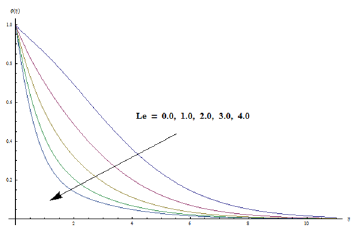
Figure 11. Variation in dimensionless concentration w ( g ) vs g for different values of Le when l 1 ~ 0 : 3, b ~ 0 : 2, M ~ 0 : 5,